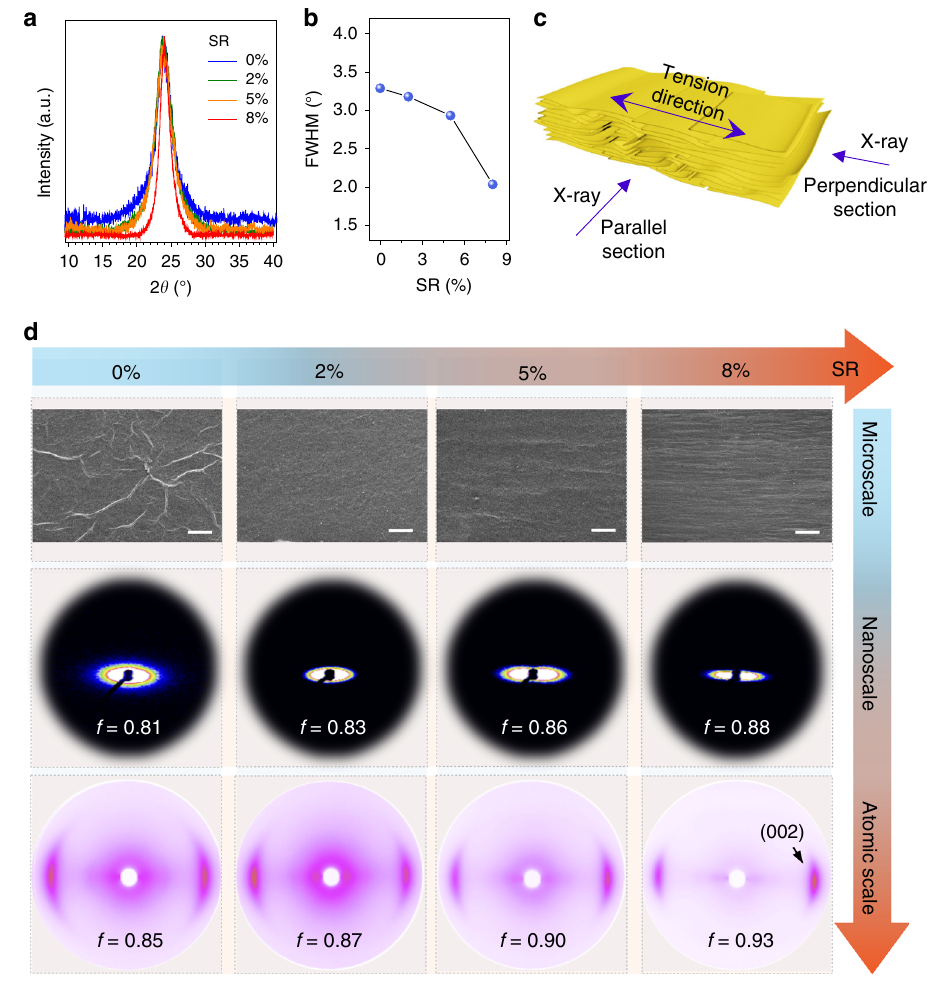
Fig. 4 Crystalline order of graphene papers. a XRD pro fi les of GPs at a serials of SR . b FWHM of (002) peak in ( a ), showing gradually aligned and homogenized crystalline structure with SR increasing. c Schematic of the SAXS and WAXS tests, in which parallel section represents that X-ray is exposed on the section parallel to the stretching direction, perpendicular section represents that X-ray is exposed on the section perpendicular to the stretching direction. d Oriented structures of GPs in micro-scale (upper row, SEM images), nanoscale (middle row, SAXS patterns) and atomic scale (bottom row, WAXS patterns). Scale bar, 100 μ m ( d